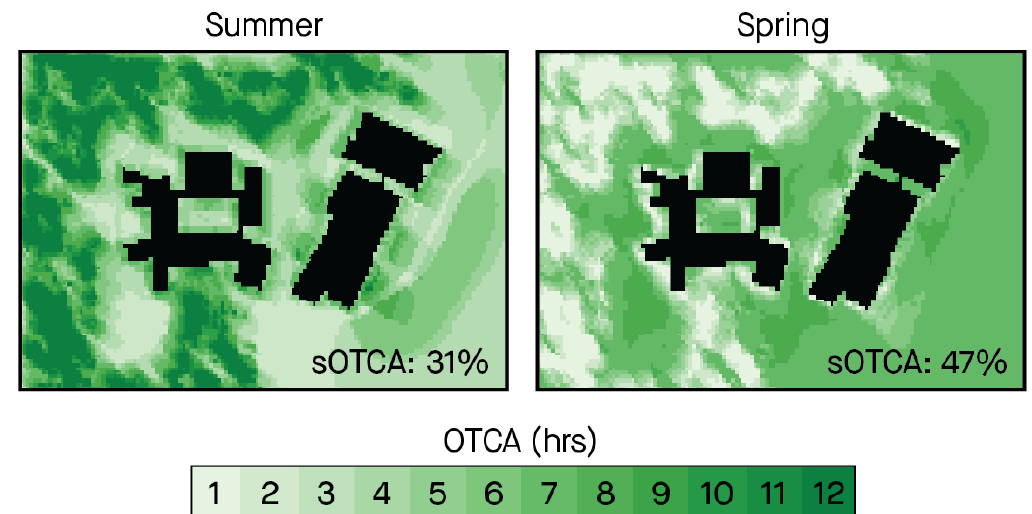
Figure 7. Outdoor Thermal Comfort Autonomy (OTCA) and Spatial Outdoor Thermal Comfort Autonomy (sOTCA) for a project in Toronto on typical summer and spring days from 6 am to 8 pm. Notice how the shadows cast by trees contribute to comfort during the summer but reduce comfort during the spring.